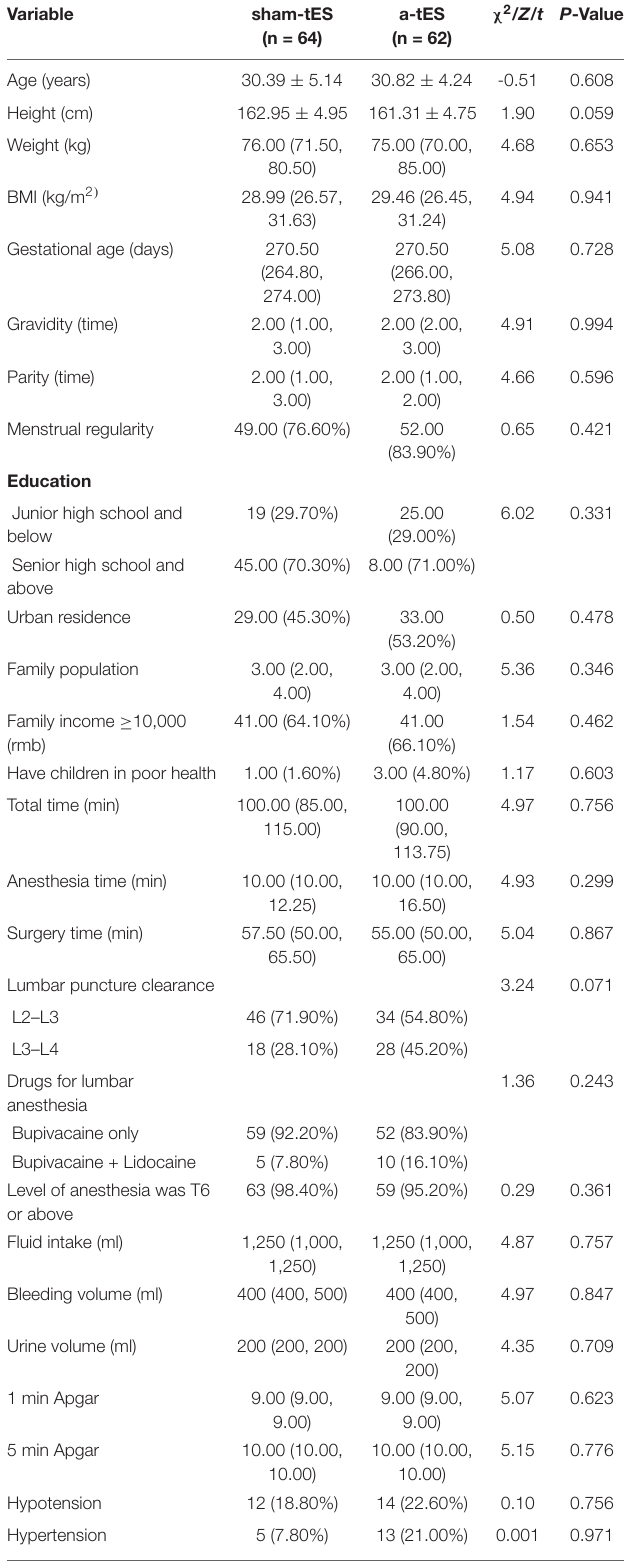
TABLE 1 | Sociodemographic and clinical variables at